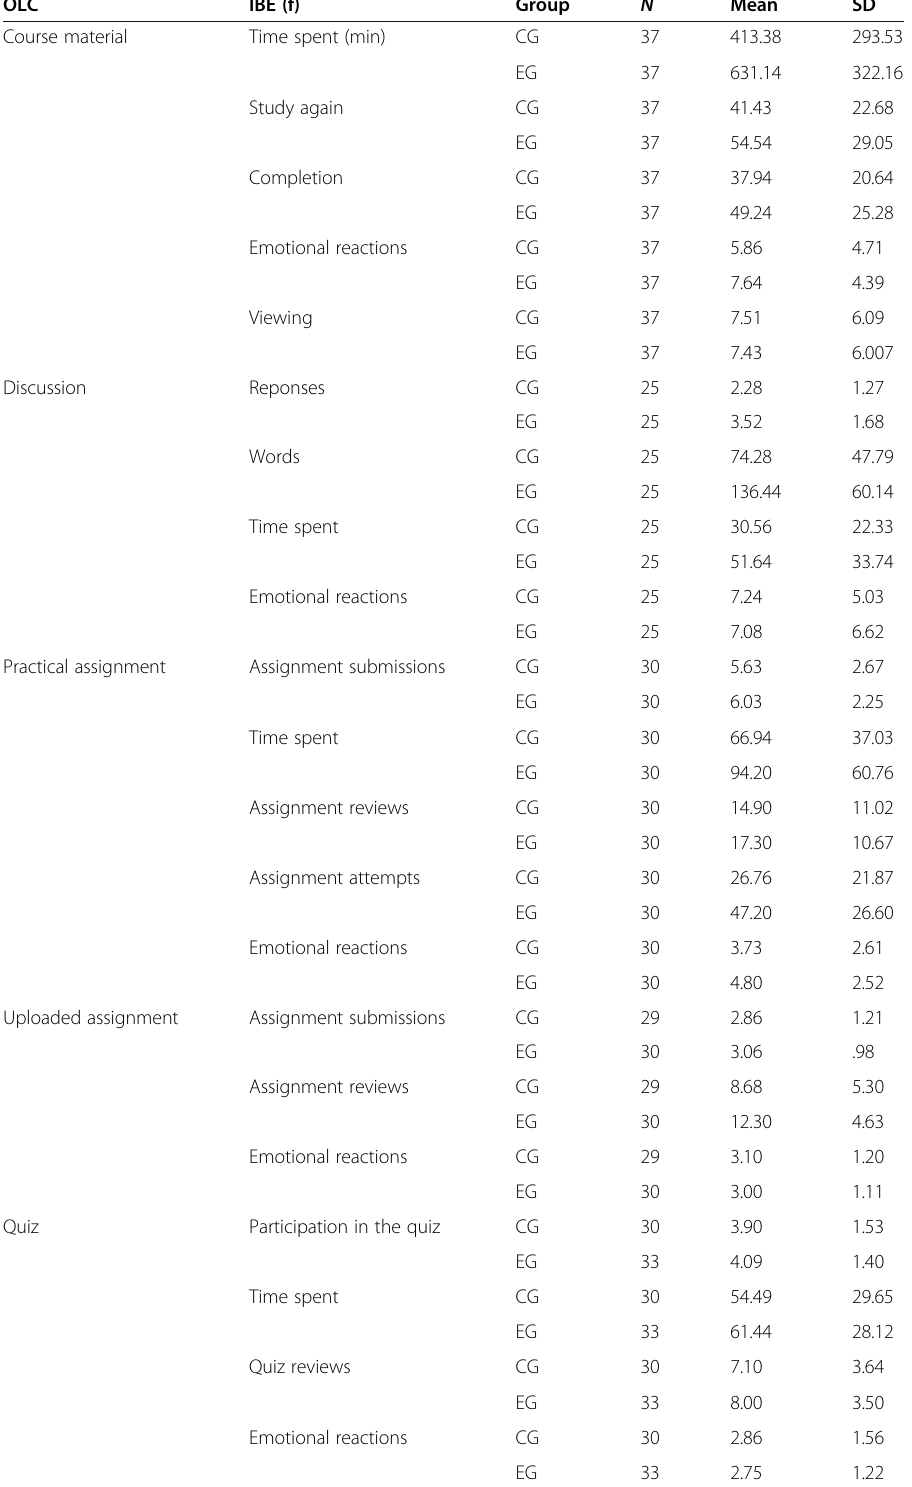
Table 4 Descriptive statistics for